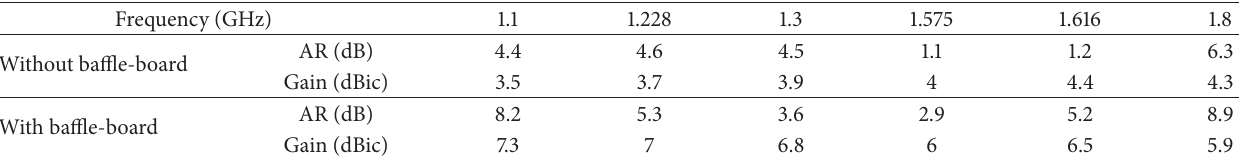
Table 5: Comparison of simulated results of axial ratio and gain.